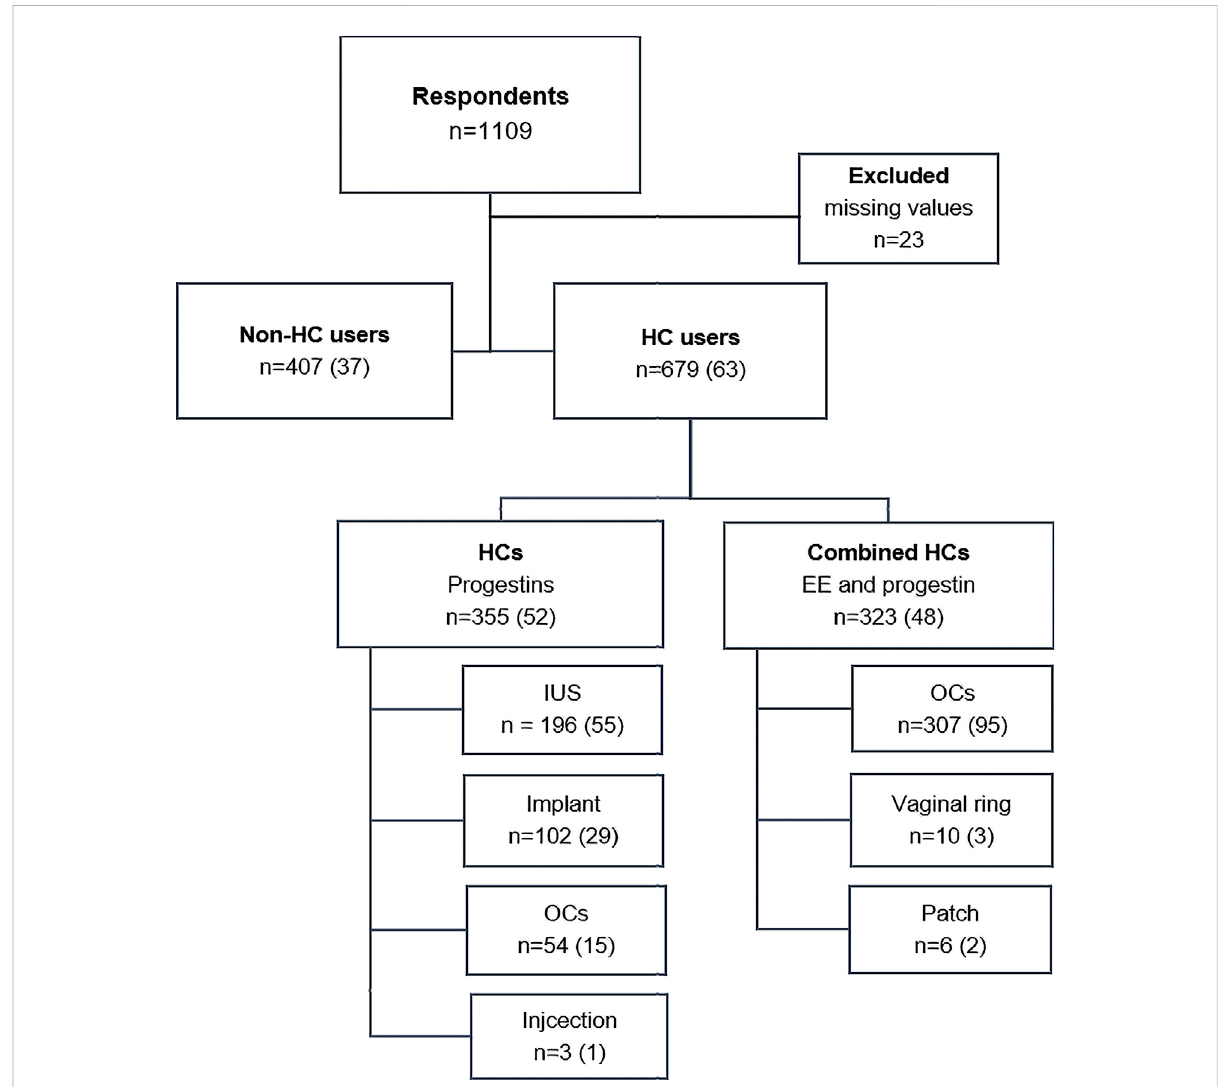
FIGURE 1 Division of the respondent athletes into users and non-users of hormonal contraceptives (HC users). Each box indicates the number ( n ) of respondents as well as the percentage (%) of the total number. EE = ethinyl estradiol; IUS = intrauterine system; OCs = oral